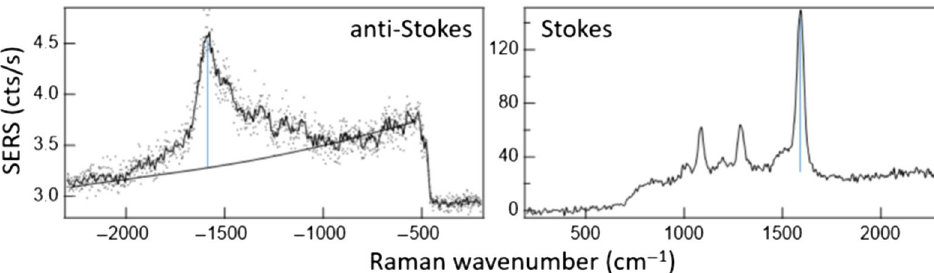
FIG. 16. Comparison of pulsed SERS from single BPT NPoM for anti-Stokes and Stokes contributions in the nonlinear